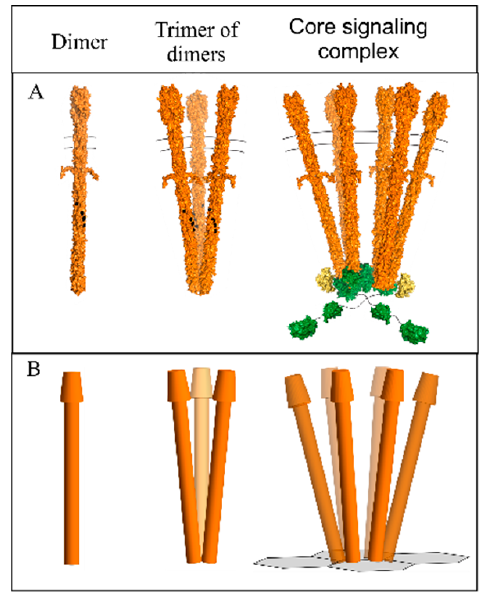
Figure 1. Chemoreceptor organizational units. Models are shown of a chemoreceptor homodimer (left), a trimer of those homodimers (center) and a core signaling complex of two trimers of receptor dimers, the dimeric histidine kinase CheA, and two copies of the coupling protein CheW. ( A ). Space-filling models. ( B ). Representations used in our geometric modeling. In the representation of a core signaling complex, two receptor trimers of dimers are placed at the vertices of the hexagonal grid of the CheW/CheA-P5 domain base plate. See the text for details.